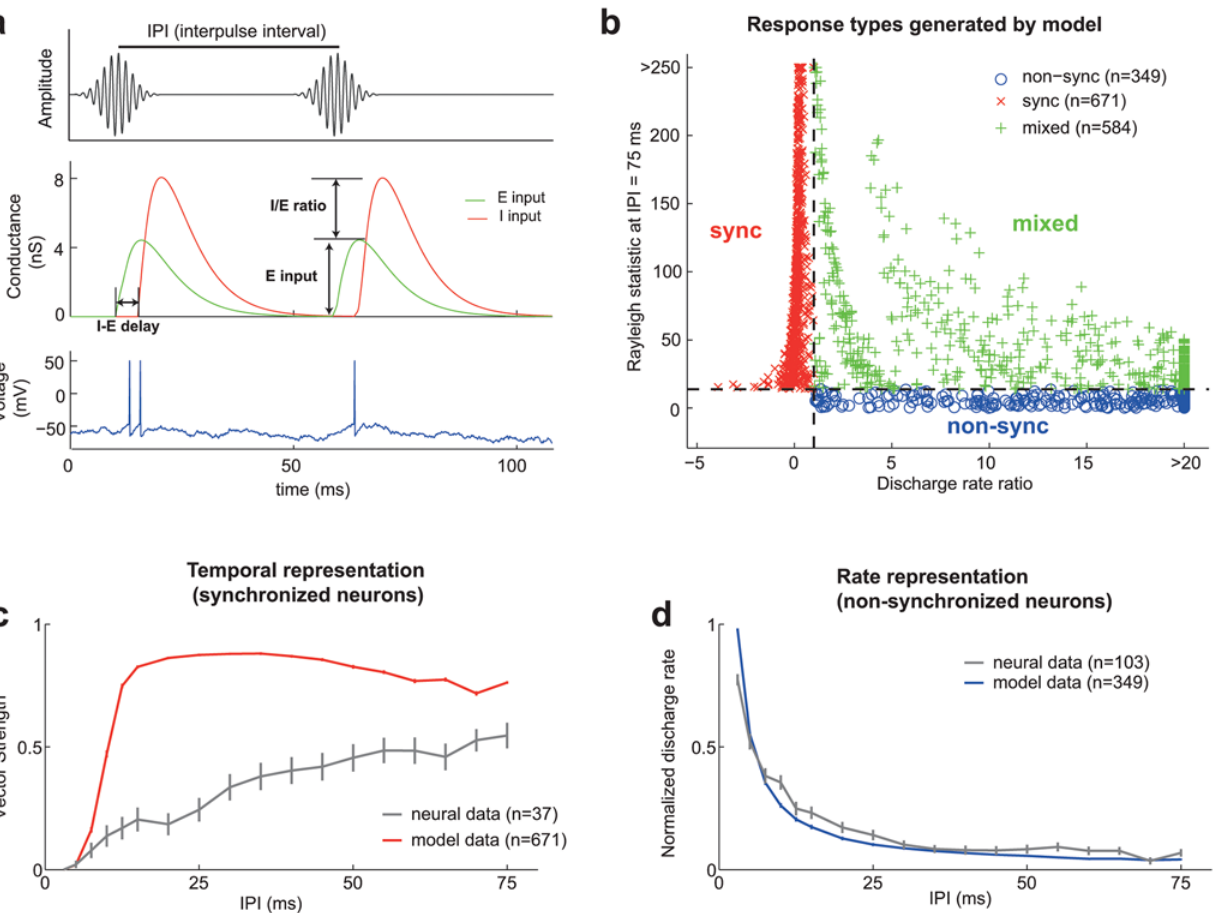
Fig 2. Computational model of an auditory cortical neuron. Error bars indicate SEM. a. The acoustic stimulus (top) used in our neurophysiological experiments was a narrowband acoustic pulse train. Each pulse was converted into an excitatory and inhibitory conductance in our computational model, using an alpha function with a time constant of 5 ms (middle). Three parameters could be altered (I-E delay, E input, and I/E ratio). Above threshold changes in the membrane voltage generated spikes (bottom), which could be further analyzed to measure the response properties of the simulated neuron. b. Classification of neural coding regime based on the two criteria (dashed lines)- y axis: Rayleigh statistic at an IPI of 75 ms > 13.8, x axis: Discharge rate ratio > 1. Neurons were classified as having a non-synchronized (o), synchronized (x), or mixed (+) response. c. Comparison of stimulus synchronization in real (gray) and simulated (red) synchronized neurons across different IPIs (3 – 75 ms). d. Comparison of normalized discharge rate in real (gray) and simulated (blue) non-synchronized neurons across different IPIs (3 – 75 ms).